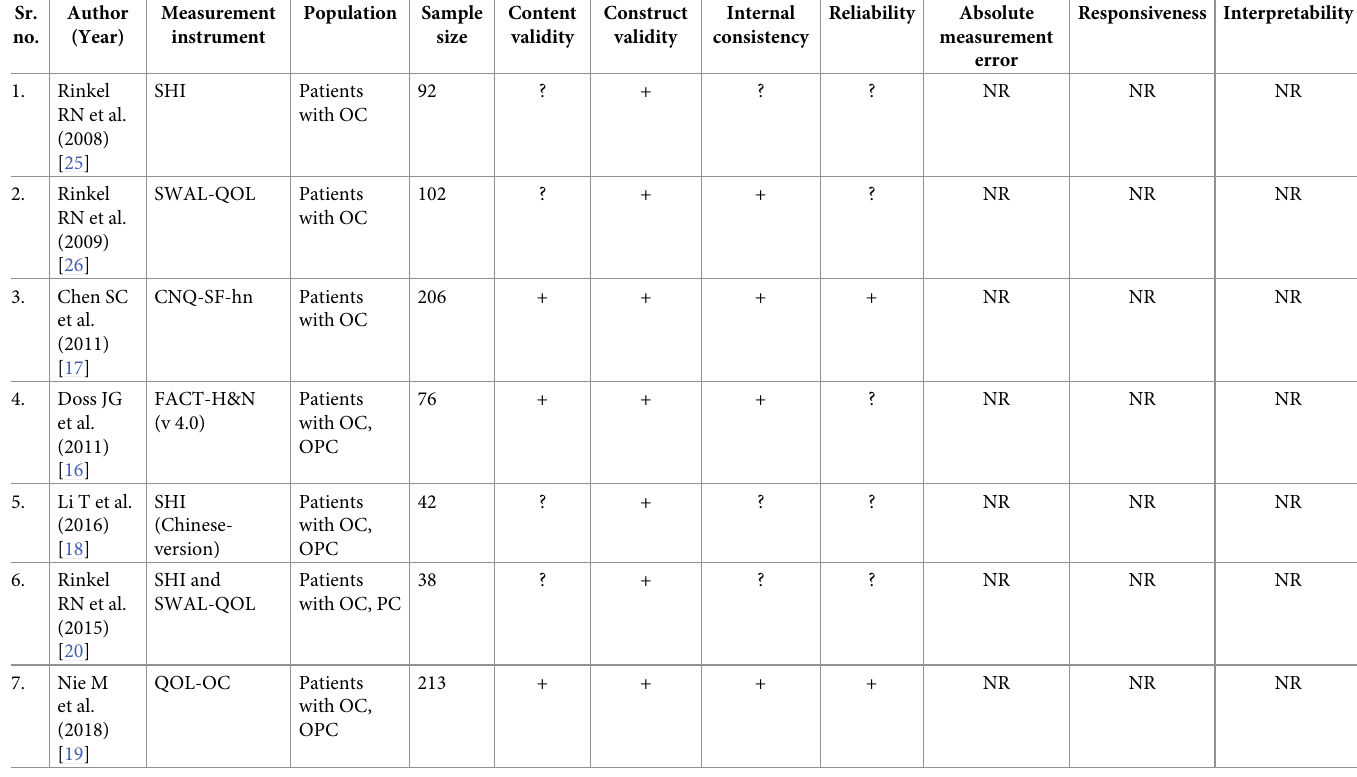
Table 2. Rating of measurement properties of the